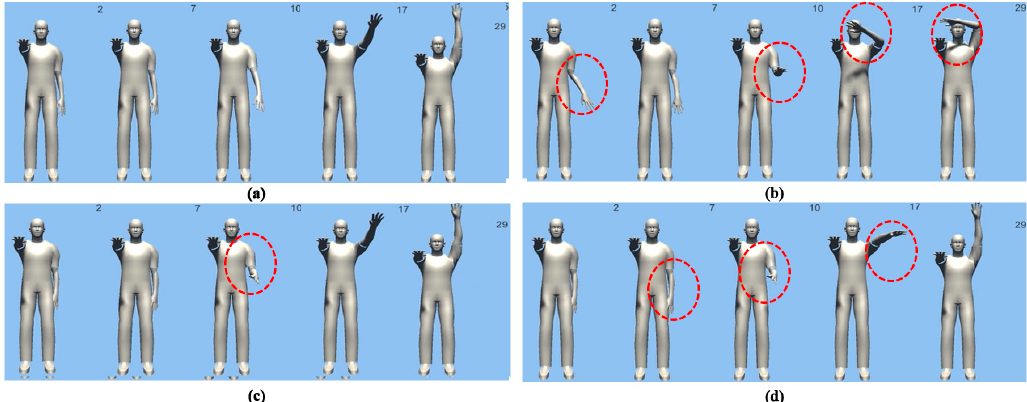
Figure 11. The following figure is a comparison of the experimental results of the previous studies on the Internal motion and the proposed studies. Motion Estimation result Screen of Proposed Method ( a ) Screenshot of raw orientation x, y, and z ( b ) Shows the results of the previous research ( c ) Shows the motion estimation result after applying the weight of the genetic algorithm ( d ) Shows the Bayesian probability estimation result that reflects the weight.